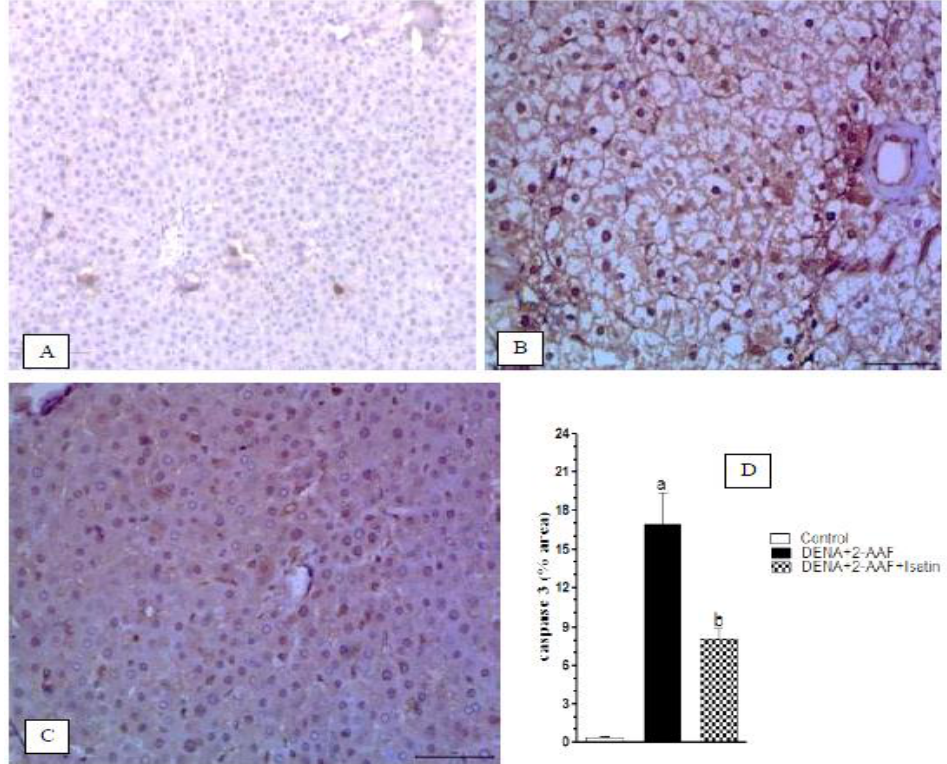
Figure 9. Isatin reduced the DENA/2-AAF-induced caspase 3 upregulation in rat liver. ( A ) Immuno- histochemically stained section depicting weak expression of caspase 3 in normal rats. ( B ) Liver of DENA/2-AAF-treated rats showed upregulated caspase 3 immunoexpression compared to normal control livers ( A ), while the livers of rats cotreated with DENA/2-AAF and isatin ( C ) showed signif- icantly reduced caspase 3 overexpression. Percent values of immunohistochemically stained areas ( D ) are presented as mean ± SEM. a p < 0.05 vs. control group. b p < 0.05 vs. DENA+2-AAF.